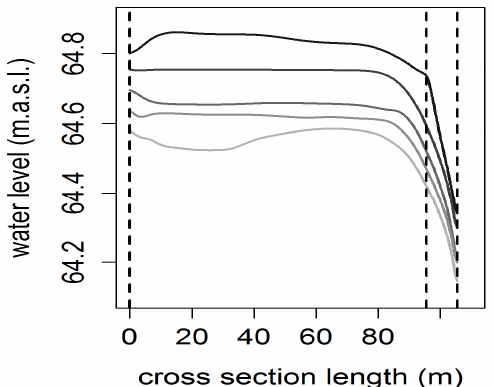
Figure 6. Evolution of groundwater levels for the model domain based on the scenario 50 cm water level in the ditches for the period of 26 April–22 May 2012 (lateral boundaries: right stream and left Ditch 2 at P5-2). The lines correspond to 0, 5, 10, 15, and 20 days of simulation time (from black to light gray). The ditches and stream are given as dashed lines.